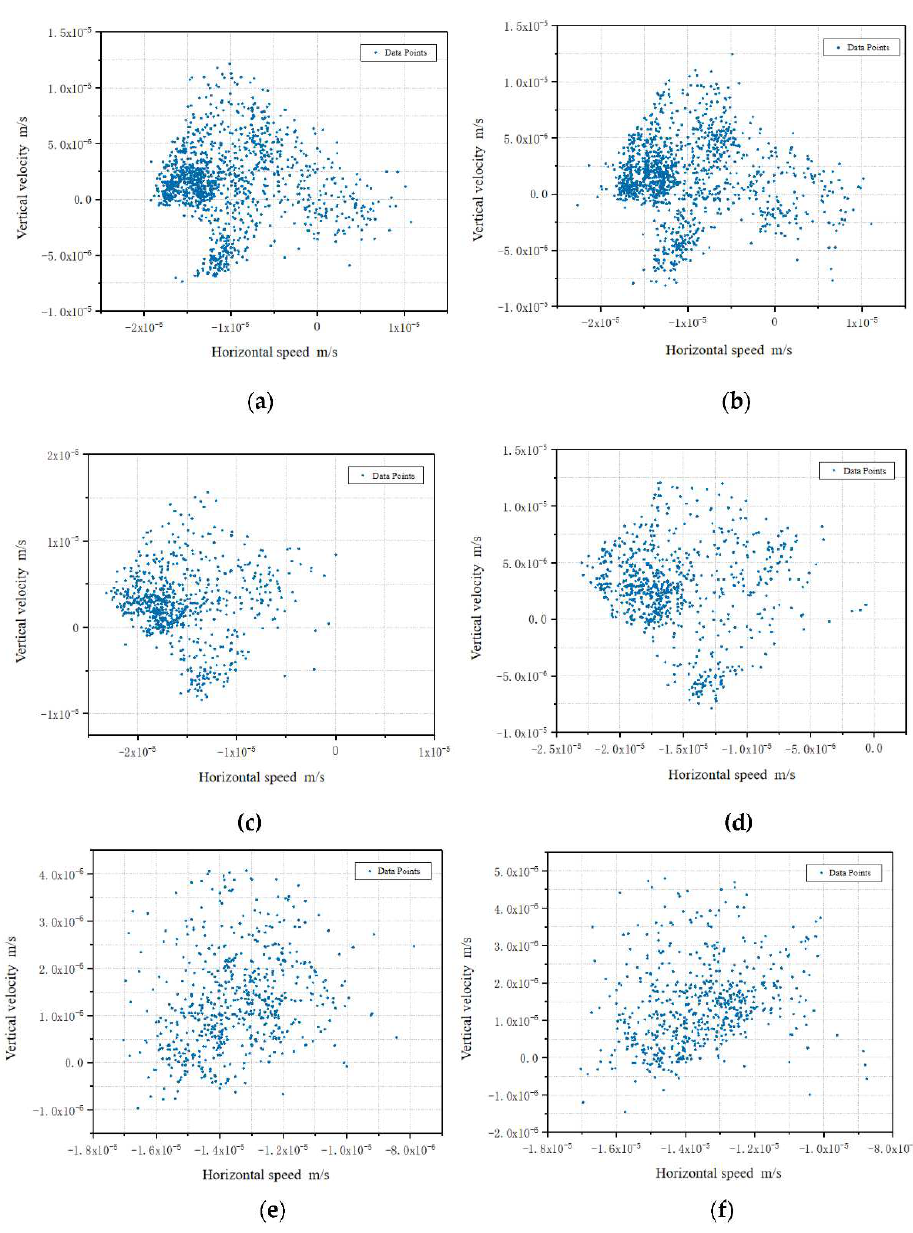
Figure 7. Comparison of seepage velocity of specimen sections with different mass ratios: ( a ) section K of a 3%-mass-ratio specimen; ( b ) section M of a 3%-mass ratio specimen; ( c ) section K of a 4%-mass-ratio specimen; ( d ) Section M of a 4%-mass-ratio specimen; ( e ) section K of a 5%-mass-ratio specimen; ( f ) section M of a 5%-mass-ratio specimen.